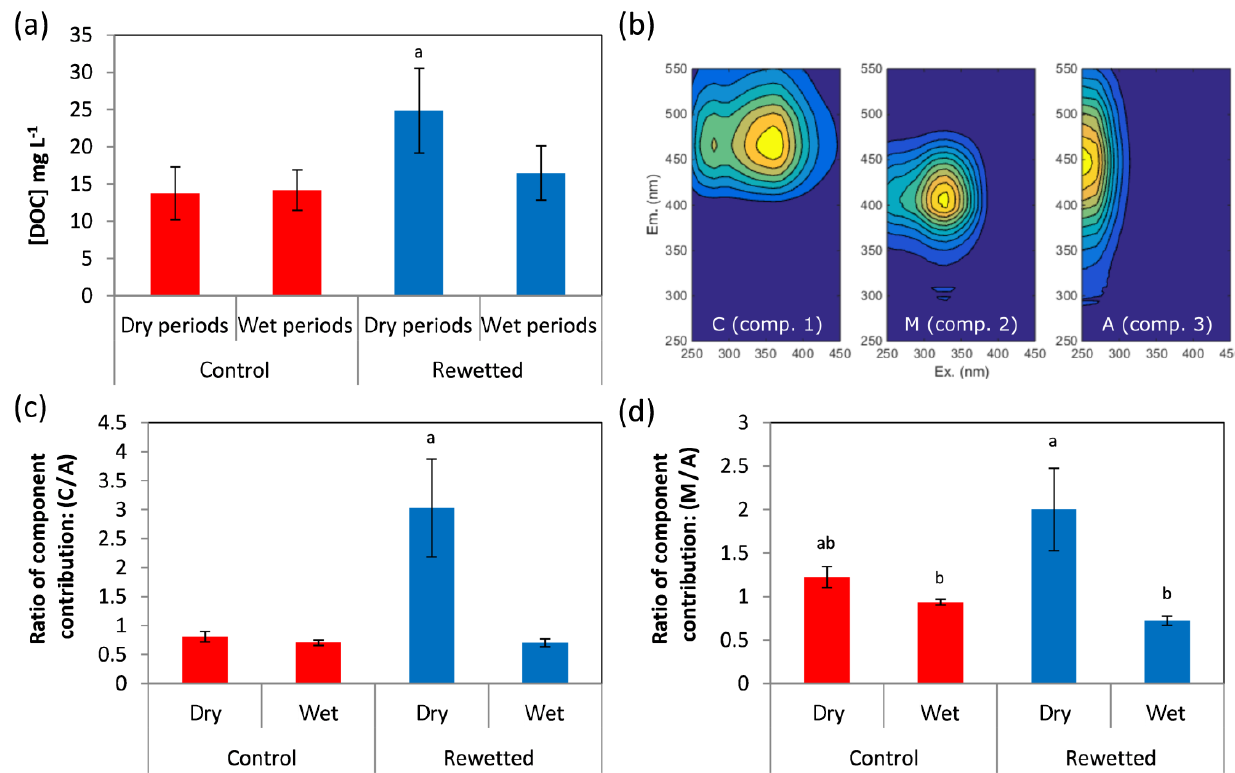
Figure 4. (a) DOC concentrations in control and rewetted sites for dry (1 June to 30 November, n = 7) and wet periods (1 December to 31 May, n = 6). (b) Excitation–emission matrices for the identified PARAFAC components (see the text for details). (c) Ratio of contribution of component C over component A for dry and wet conditions in control and rewetted sites ( n = 4). (d) Ratio of contribution of component M over component A for dry and wet conditions in control and rewetted sites ( n = 4). The letter above the bar indicates significant differences across different conditions (Tukey’s p< 0 . 01).